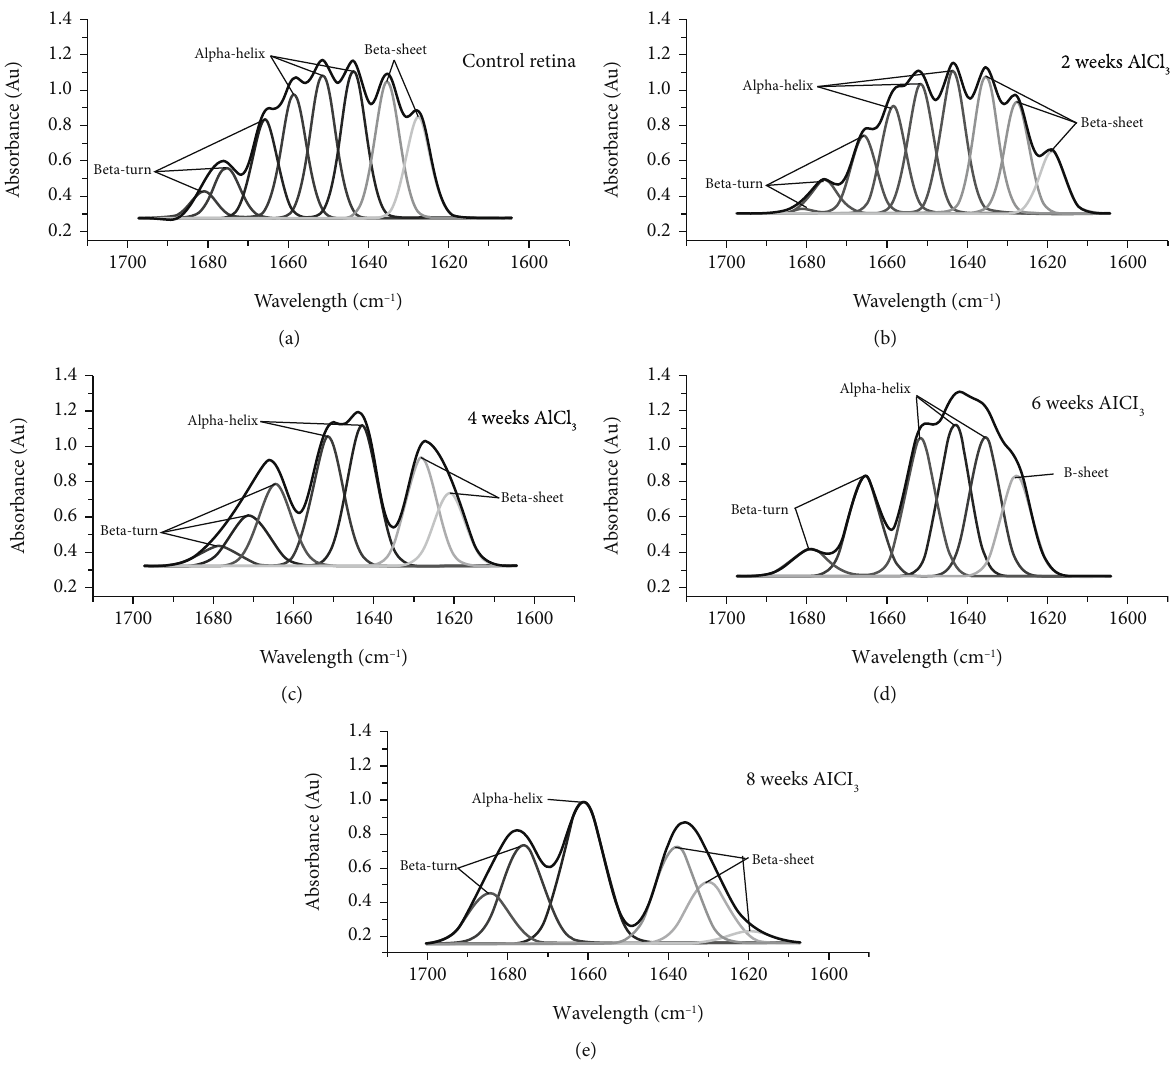
Figure 3: FTIR spectra (1700-1600cm 1 ) of amide I band of the retinal tissue after deconvolution for the control rat group (a) and all groups administrated aluminium chloride after 2 weeks (b), 4 weeks (c), 6 weeks (d), and 8 weeks (e). Table 2: Curve fi tting analysis of amide I bands represents the percentages of area under peak (%) of main protein secondary structural components ( β -turn, α -helix, and β -sheet) of rat ’ s retinal tissue in all groups administrated aluminium chloride compared to control.